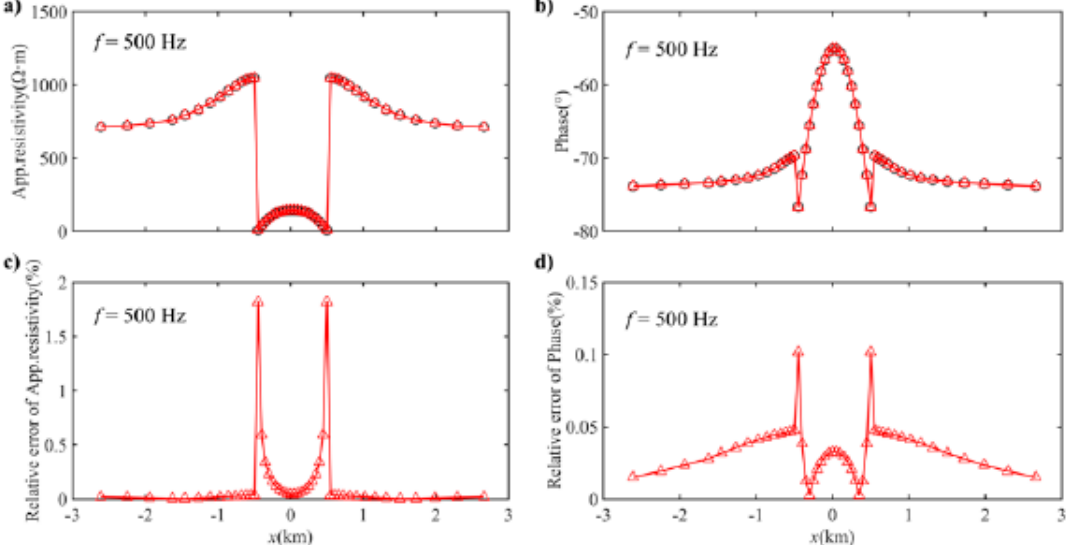
Figure 11. Comparison plots of the apparent resistivity ( a , c ) and phase ( b , d ) from the case based on the quasi-static approximation (upward-pointing triangle lines)) with 10 − 6 S / m for air conductivity, and the one with the complete wavenumber (circle lines) at frequency of 5 × 10 2 Hz for the steep hill model. The relative errors are referenced to the results based on the use of the complete wavenumber.